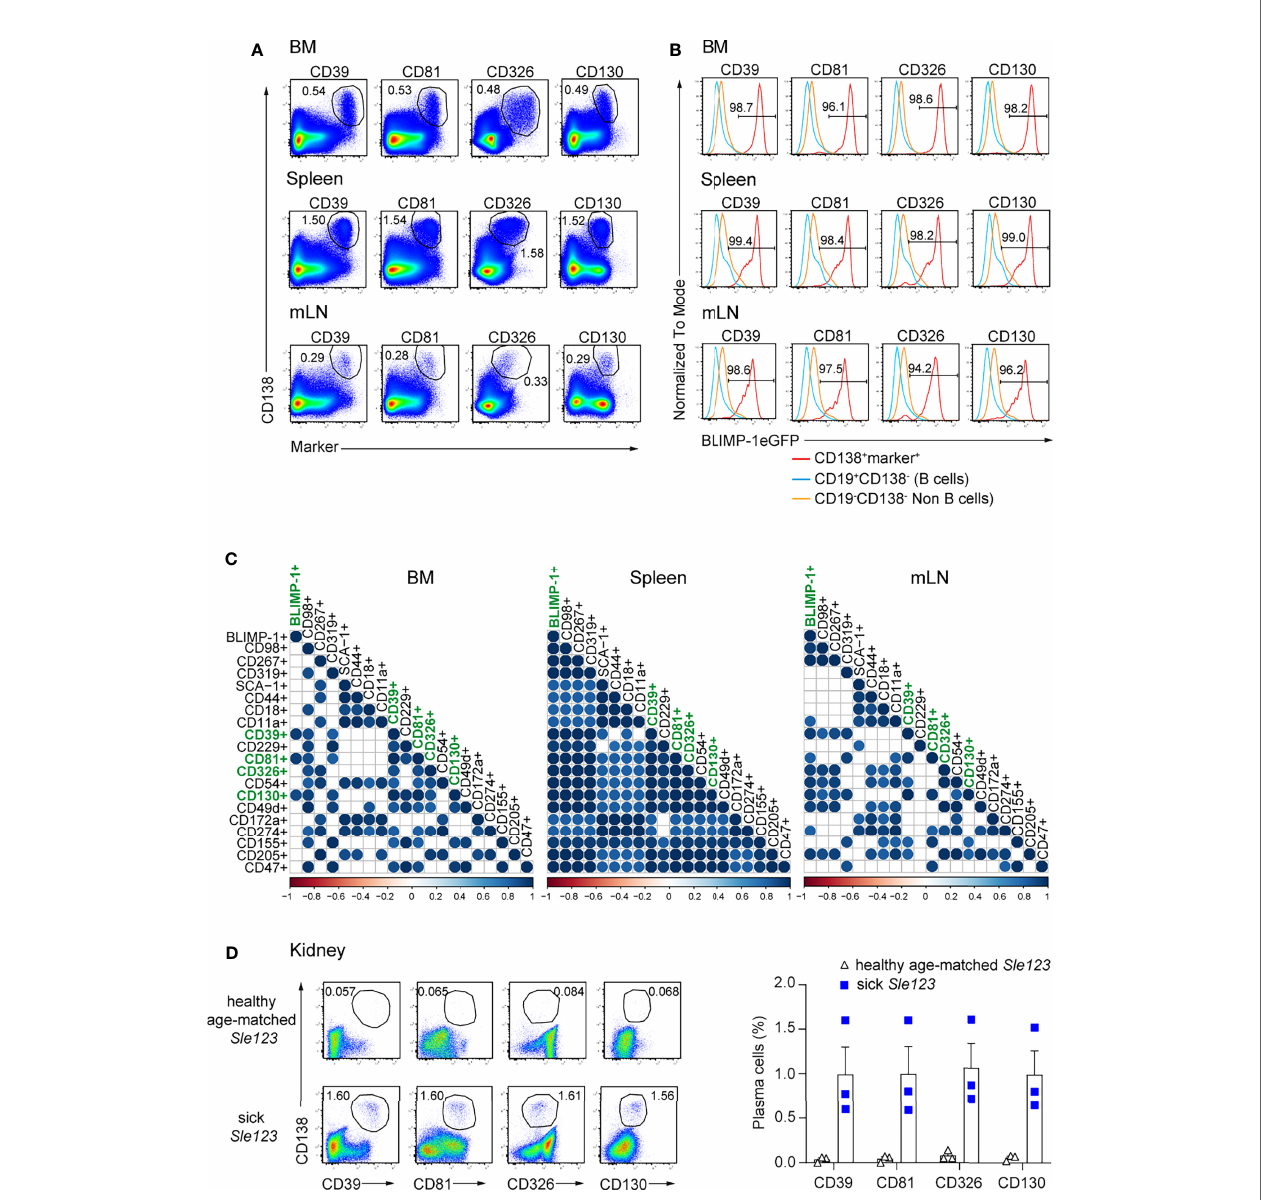
FIGURE 2 | ASCs in naive mice are reliably identi fi ed by surface expression of CD39, CD81, CD326, and CD130. Analyses were performed with naive prdm1 eGFP mice, unless indicated otherwise. (A) Representative FACS plots show the co-expression of CD138 with indicated markers on ASCs from BM, spleen, and mLN. The populations were gated on live cells. (B) Representative histograms showing frequencies of BLIMP-1eGFP + cells within ASC populations as gated in (A) , CD19 + CD138 - B cells and CD19 - CD138 - non-B cells obtained from BM, spleen and mLN. (C) Spearman correlation matrix of ASCs populations (frequencies) de fi ned by co-expression of CD138 and the indicated marker as shown in Panel (A) and Supplementary Figure 2 . Positive correlation is displayed in blue with color intensity and size of circle re fl ecting correlation coef fi cients. Only correlations with p<0.01 are shown. (A, B) FACS plots and FACS histograms are representative of two independent experiments (n=6 mice). (C) The data were from two independent experiments (n=6 mice). (D) Representative FACS plots (left) and frequencies (right) of ASCs de fi ned by co-expression of CD138 and the indicated marker in kidneys from sick (proteinuria >300mg/dL) and healthy age-matched Sle123 mice (n=3 mice/group). The populations were gated on live cells. Data show mean ±